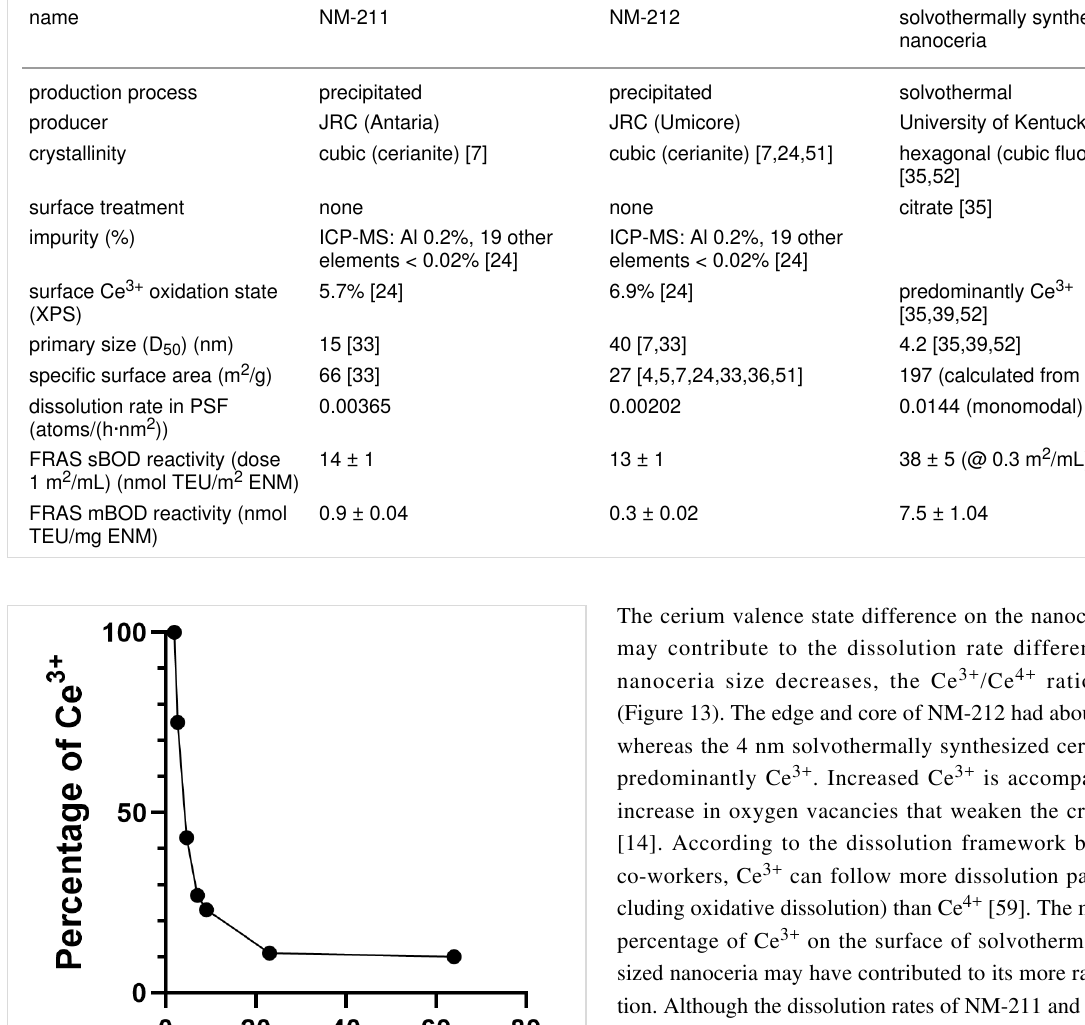
Table 3: Production process, producer, physicochemical properties, and reactivity of NM-211, NM-212, and the solvothermally synthesized nanoceria.